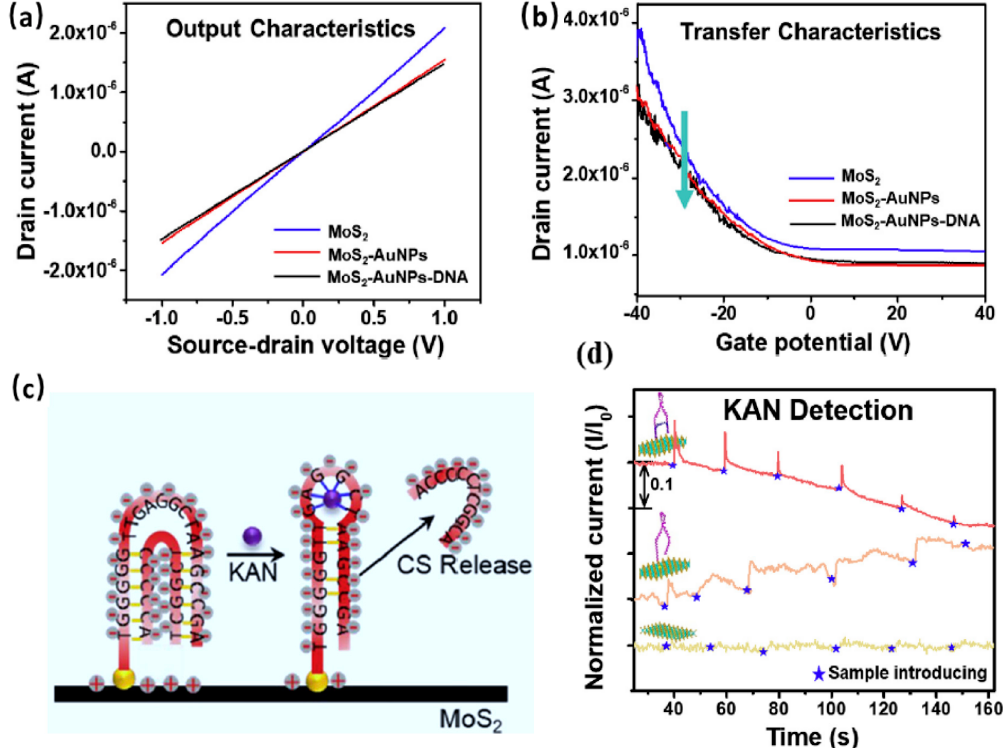
Figure 4. ( a ) I sd -V sd curve showing the Ohmic contact of the device. ( b ) FET characteristic curves of the device. ( c ) The proposed mechanism of Kanamycin (KAN) replacing CS. ( d ) The sensor system, with control experiments, response to KAN at different concentrations. Reprinted from ref [41], Copyright (2019), with permission from Elsevier.